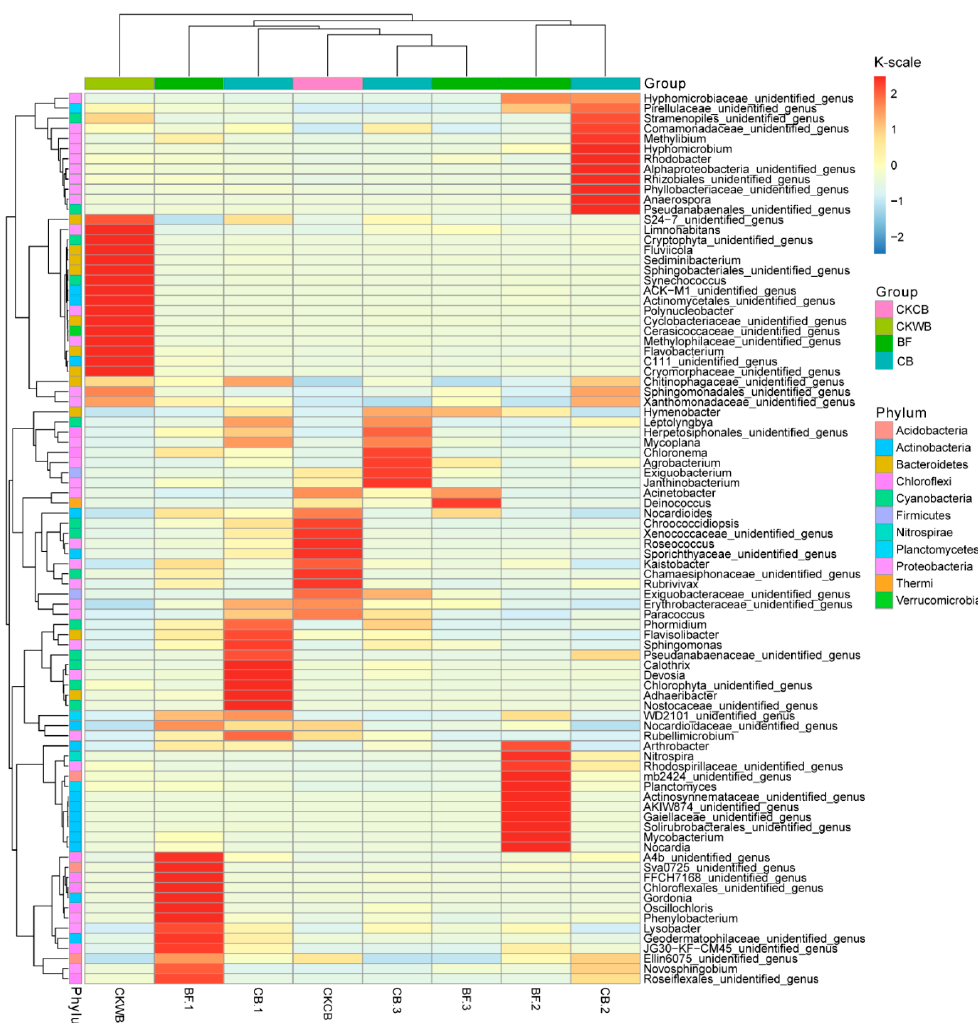
Figure 6. Heatmap diagram for the dominant prokaryote genera.